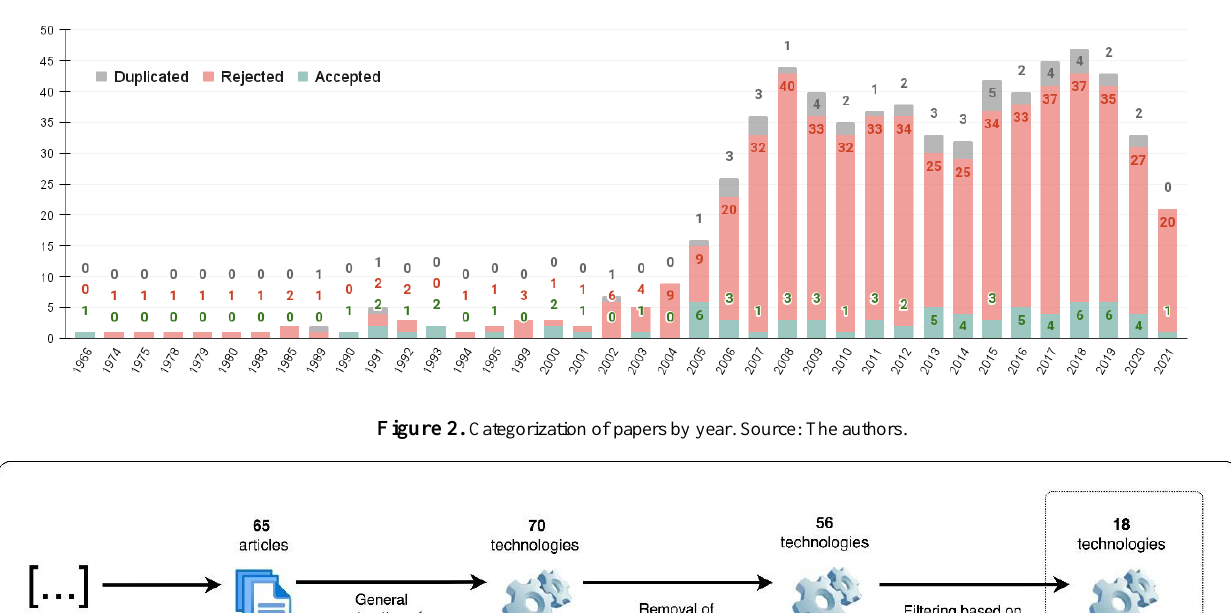
Figure 1. Research methodology used in systematic mapping. Source: The authors.